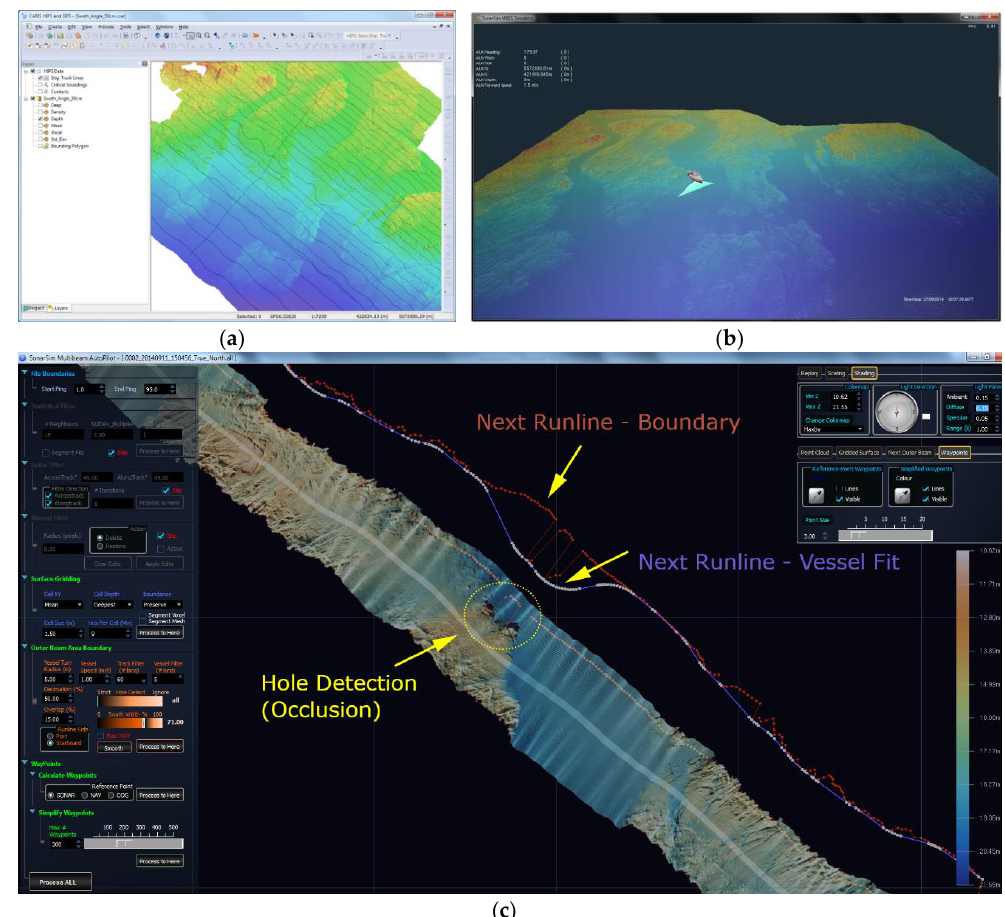
Figure 6. ( a ) A surface model from the Plymouth Sound Common Dataset displayed in Caris HIPS. ( b ) The simulator scenario execution of a survey runline. ( c ) Simulator runline planning software to adaptively calculate runlines based on quality of acquired coverage.